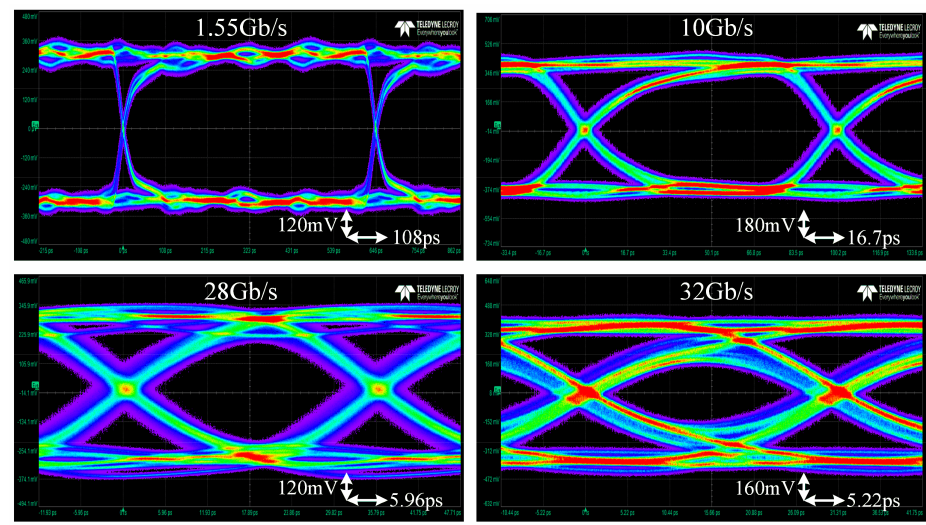
Figure 9. Measured output eye diagrams of the proposed TX lane-0 at 1.55/10/28/32 Gb/s.